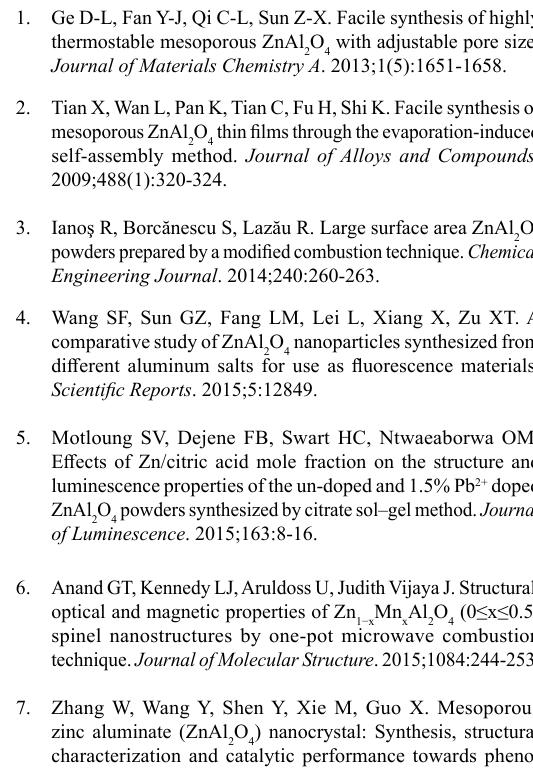
O MC and (b) ZnAl 2 4 –